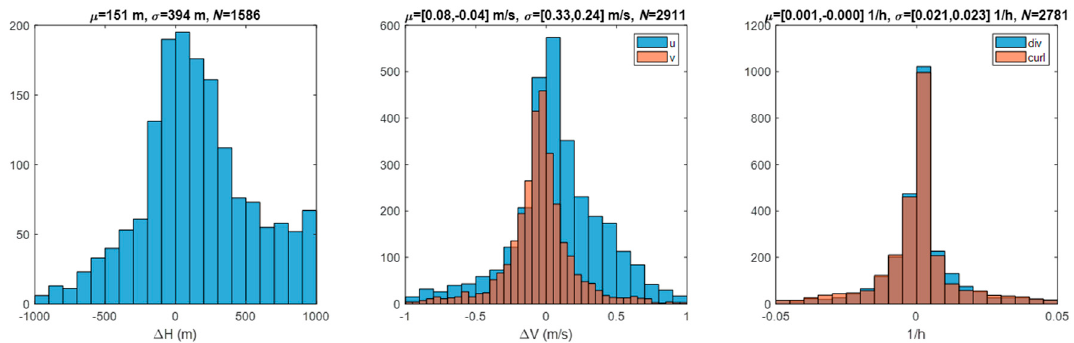
Figure 7. Ground-point retrievals in B14 at 2020/207 17:20Z from GOES-16 and -17 FDs using a 24 pixel × 24 pixel template and 12 pixel × 12 pixel sampling.